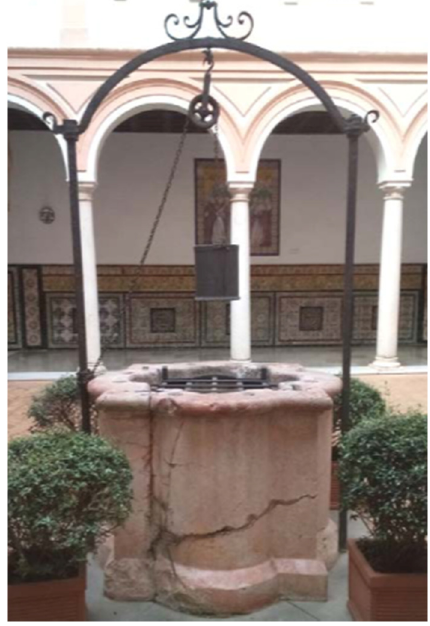
Figure 2. “The well of the garden has a bucket hanging on it. Imagine that there is an ant alone inside the bucket and wants to get out by climbing up the wall. If it walks 10 cm in 1 min, how much time will it take to walk the whole bucket?”.